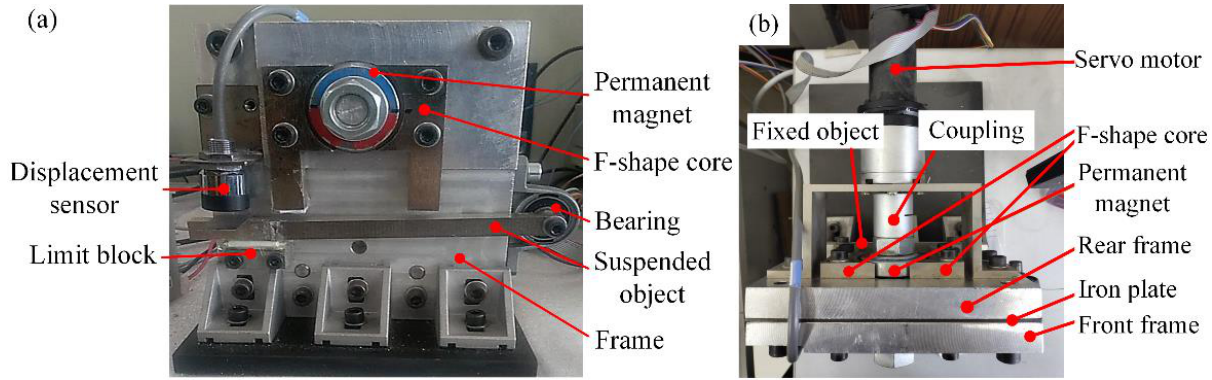
Figure 7. The experimental prototype: ( a ) the front of the prototype; ( b ) the back of the prototype.